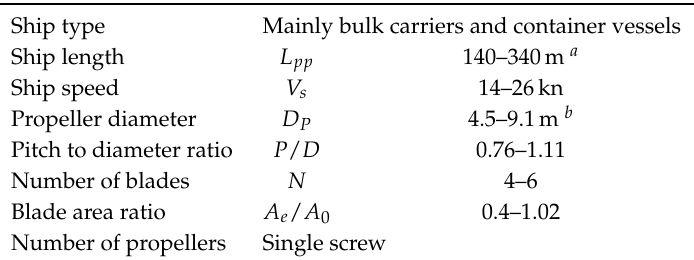
Table 7. Range covered by the 35 ships included in the final